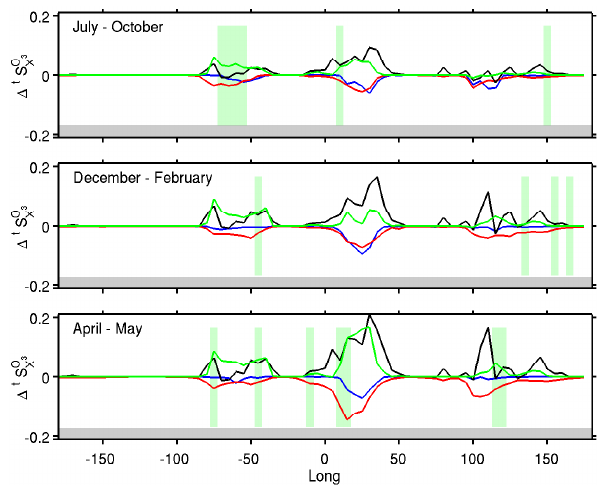
Fig. 10. Absolute changes in the adjoint sensitivity of tropospheric tropical ozone resulting from a large increase in anthropogenic emissions of NO x (cf. Sect. 4.4 1 t S O 3 = t S O 3 (high tropical NO x X X emissions) − t S O 3 (reference), with t S O 3 in % / ◦ ) to changes in the X X emissions of isoprene (green), lightning NO x (red), biomass burn- ing NO x (blue) and anthropogenic NO x (black) resulting from a very large increase in anthropogenic NO x emissions. Green-shaded areas denote regions where t S O 3 become positive because of higher X NO x emissions. The grey shaded region denotes the regions over which the cost function are